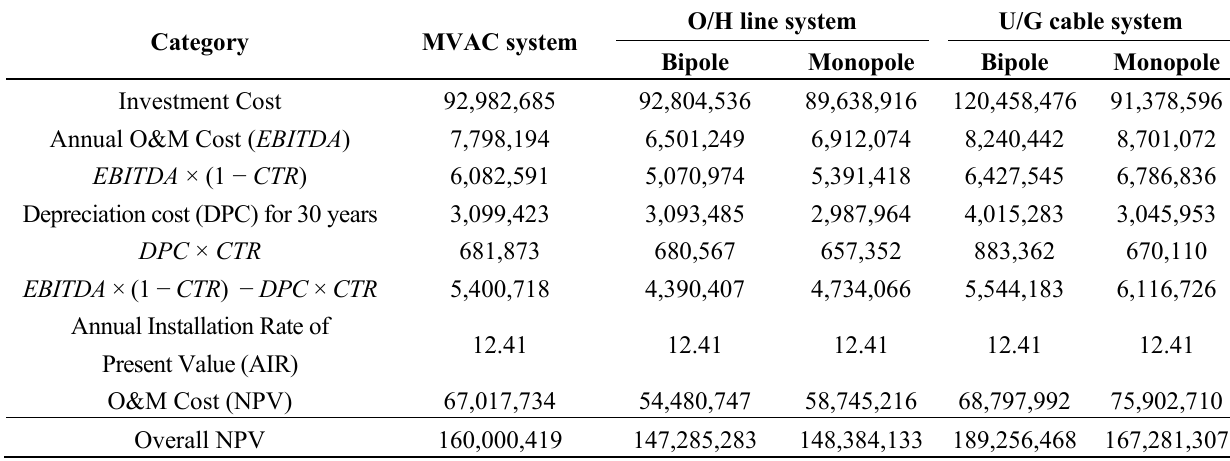
Table 14. NPV analysis for 30 years